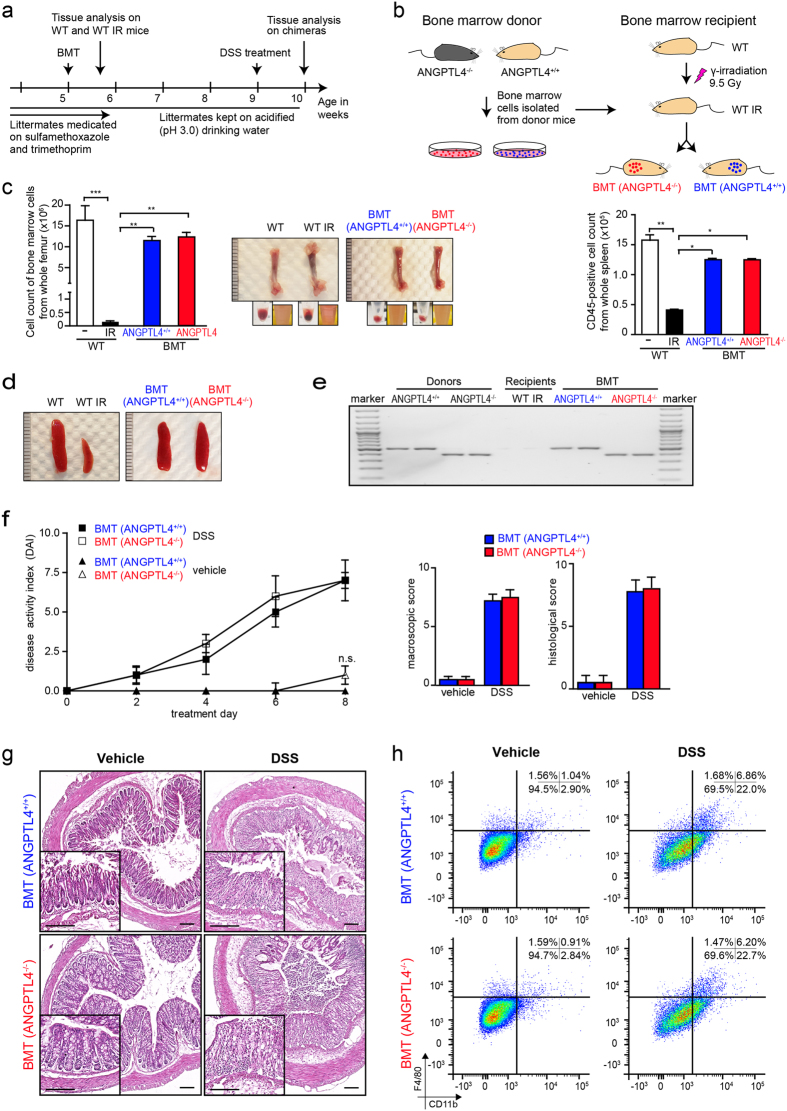
Intrinsic role of colonic ANGPTL4 in leukocytes infiltration during DSS.(a,b) Graphical illustrations depicting the experimental setup for bone marrow transplantation (BMT). CD4+ and CD8+ depleted bone marrow cells from age- and gender-matched ANGPTL4+/+ or ANGPTL4−/− donors were transplanted into γ-irradiated ANGPTL4+/+ wild-type recipient (WT IR). Chimera BMT ANGPTL4+/+ and BMT ANGPTL4−/− denote WT IR transplanted with bone marrow cells from ANGPTL4+/+ and ANGPTL4−/− donor, respectively. Graph showed the number of CD45+ cells from spleen of indicated mice (Mean ± S.D.; n = 6 mice per group). (c,d) Representative images of the femur (c) and spleen (d) from indicated mice (WT and WT IR) and chimeras (BMT ANGPTL4+/+ and BMT ANGPTL4−/−). Inserts in (c) showed the bone marrow cell pellet before and after red blood cell lysis. Graph in (c; left panel) showed the number of bone marrow cells from femur of indicated mice (Mean ± S.D.; n = 6 mice per group). (e) Representative agarose gel image of genotype PCR products from CD45+ splenic cells from indicated mice. (f) Graphs showing the disease activity index (DAI; left panel), macroscopic score (middle panel) and histological score (right panel) of indicated mice treated with vehicle or 2% DSS. Individual scoring criteria can be found in Supplementary Tables S1–S3. (g) Representative hematoxylin and eosin (H&E) images of colon section from vehicle and DSS treated mice post BMT. (h) Representative FACS analysis for CD11b+ and F4/80+ cells from colons of BMT ANGPTL4+/+ and BMT ANGPTL4−/− chimeras treated with vehicle or DSS. n = 6 per group. The Mann-Whitney U test was used. *p < 0.05; **p < 0.01 and ***p < 0.001. n.s. denotes not significant.